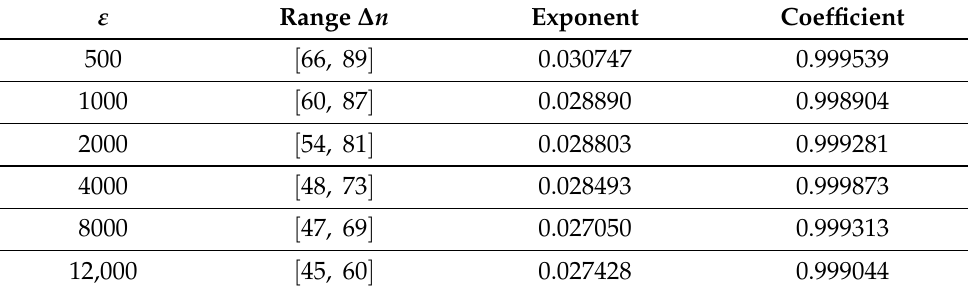
Table 10. Maximal Lyapunov exponents for coop2 (differences).